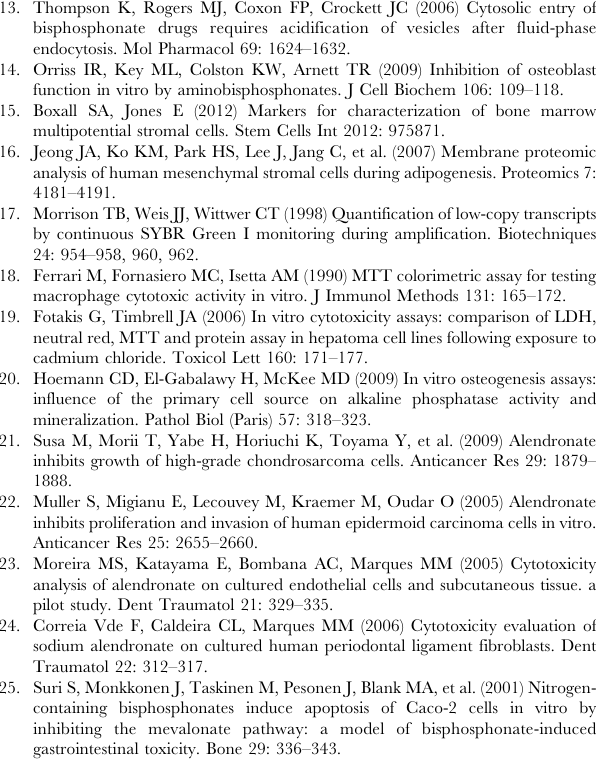
Figure S3 Treatment of FPP or GGPP did not affect the expression of BMP-2 and Runx-2 in hBMSCs. The mRNA expression of BMP-2 and Runx-2 in FPP or GGPP-treated hBMSCs were measured through two weeks. Cultured hBMSCs were untreated (control) or treated with 10 m M FPP (grey bars) or 10 m M GGPP (black bars) in bone medium for five days and then shift to osteo-induction medium without FPP or GGPP. Compare with the control, n =3. (TIF) Figure S4 The reversal effects of different concentra- tions FPP or GGPP on mineralization of Aln-treated hBMSC with group B. The mineralization effects and cell viabilities of Aln-treated hBMSCs with group B were determined after additional treatment with 5 m M (light grey bars), 10 m M (deep grey bars) and 20 m M (black bars) FPP (A) or GGPP (B). The ARS staining was performed at day 15 and day 20. The mineralization levels are shown as photographs and the quantified data shown as bar graph compared to 5 m M Aln-treated group. * p , 0.05, n= 3, compare with 5 m M Aln treatment. (C) The ALP activities of 5 m M Aln-treated only or with additional 10 m M FPP or 10 m M GGPP were measured at day